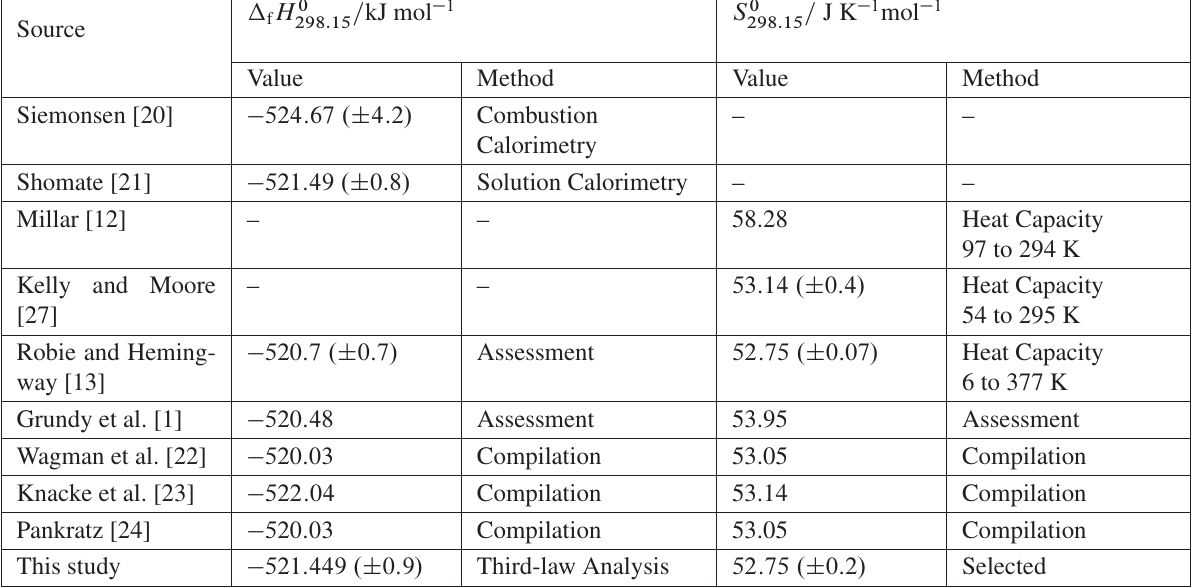
Table 7. Comparison of data for MnO 2 selected in this study with values reported in the literature. T= K C 0 p